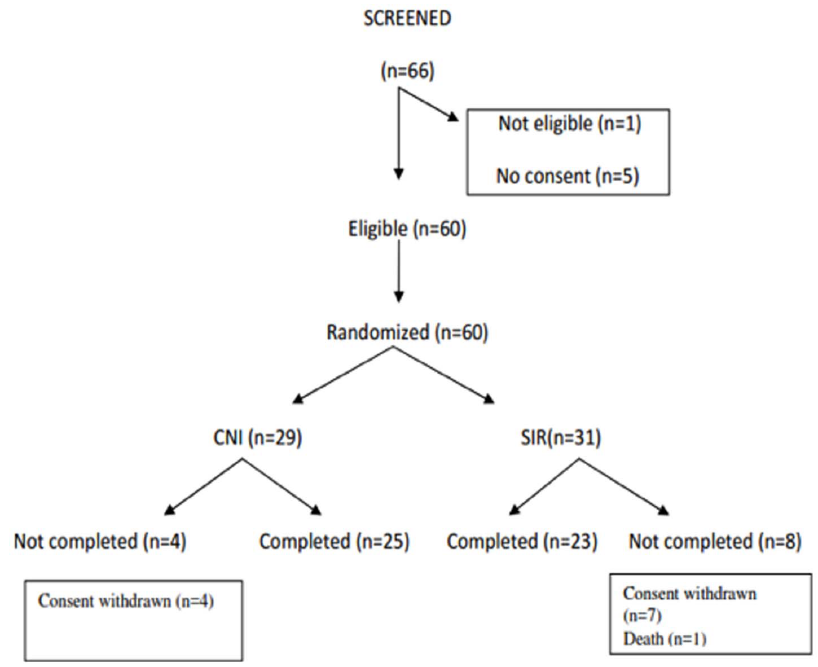
Figure 1. Study design, randomization, and follow up.